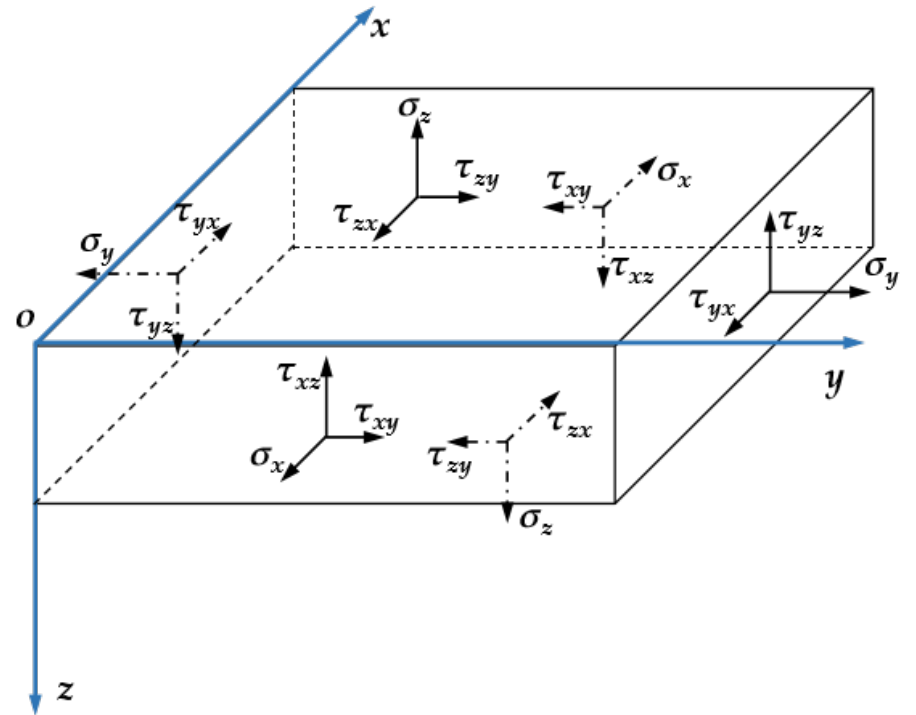
Figure 3. Schematic diagram of the elastic mechanic model for the basic roof.